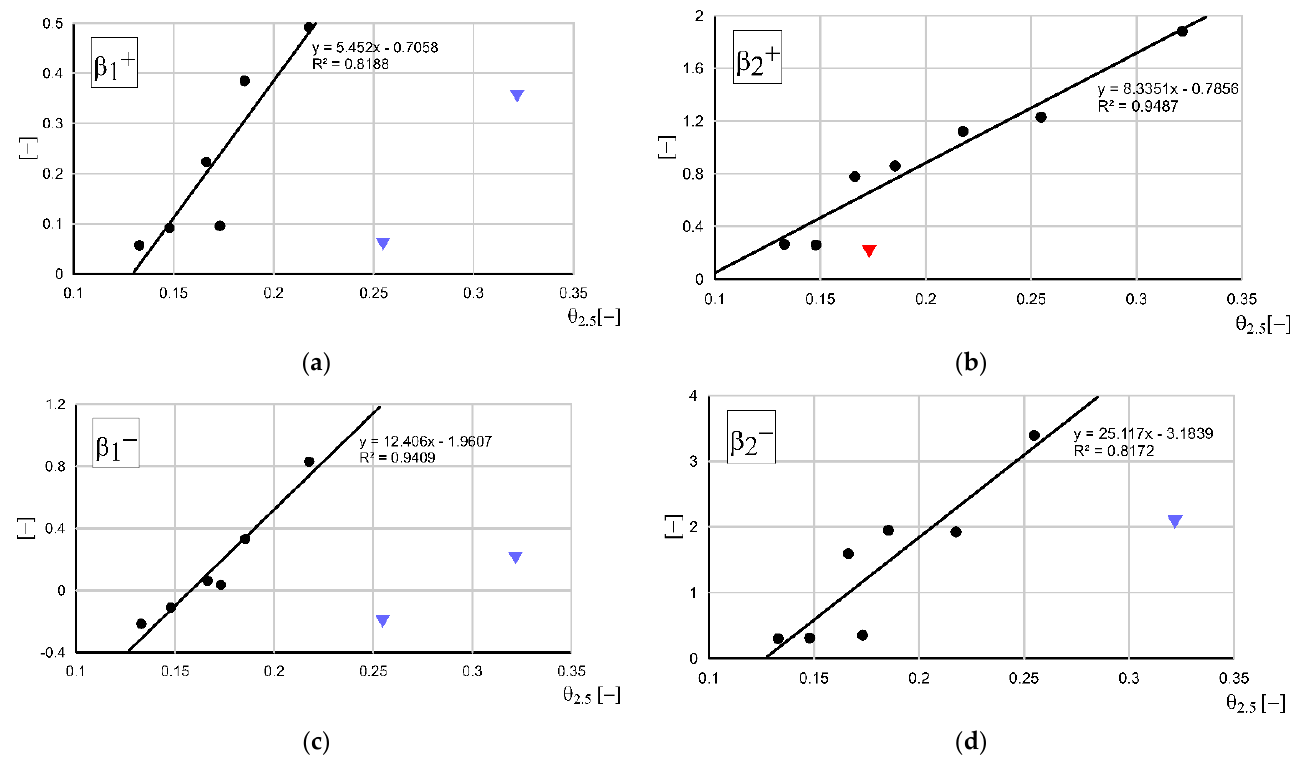
Figure 8. Plots of sediment flux correction factors: ( a ) fine fractions, crest phase; ( b ) coarse fractions, crest phase; ( c ) fine fractions, trough phase; ( d ) coarse fractions, trough phase.